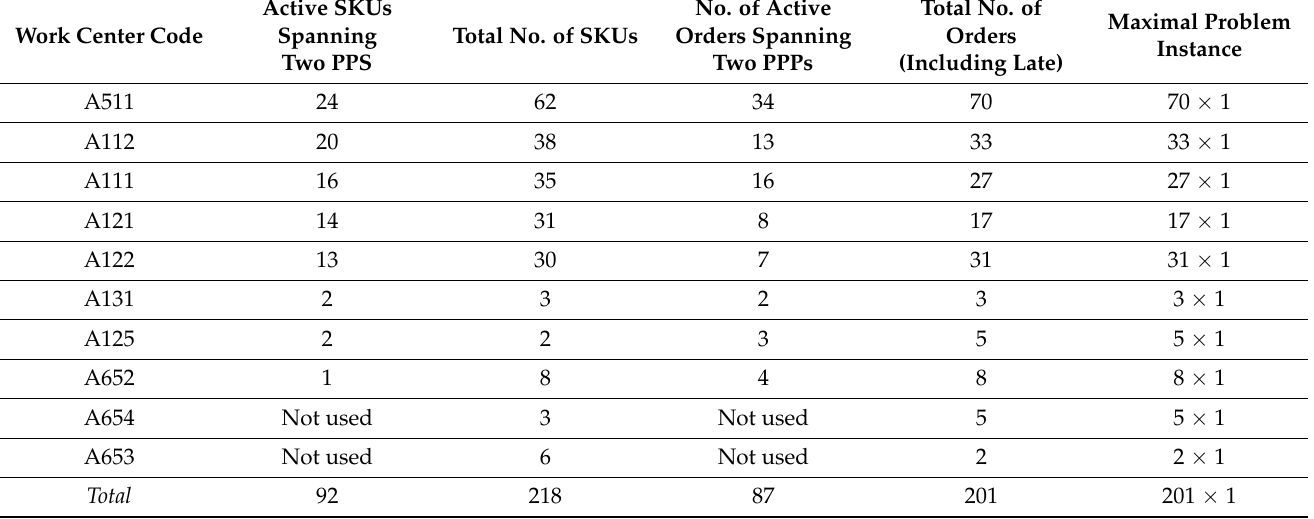
Table 4. Cutting group n × 1 problem